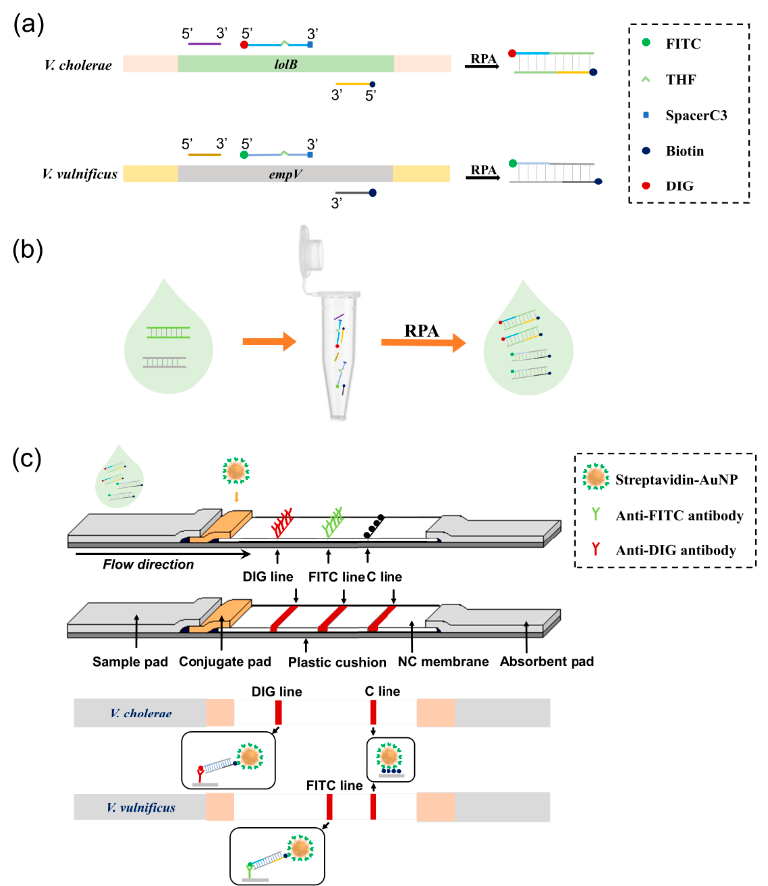
Figure 1. Schematic diagram of the duplex RPA-LFS biosensor. ( a ) Target amplification by RPA of the two Vibrio species. The target genes for V. cholerae and V. vulnificus were shown as horizontal strips. Primers and probes were shown as horizontal lines. Labels and modifications on the probes, the reverse primers and the RPA products were indicated. ( b ) Target amplification in the duplex RPA reaction. The duplex RPA system contained primer/probe sets for both detection markers. Both targets could be amplified with appropriate labels on the amplicons. ( c ) Simultaneous differential detection by visualization lines on the 3-segment strip: DIG, FITC and C (control) lines. The structure of the strip was shown with the coating materials indicated. RPA products from V. cholerae gave signal at the DIG line and that from V. vulnificus gave signal at the FITC line because of the different labels. Signal at the C line indicated proper finish of the lateral flow